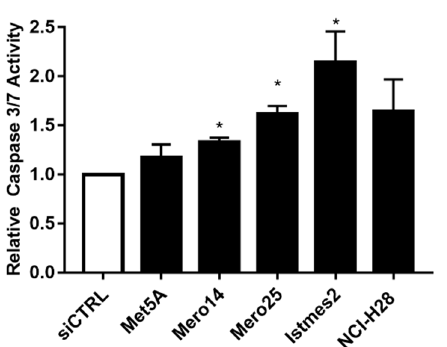
Figure 8. RAN silencing and caspase-3 and -7 activities. Caspase activity measured in MeT-5A and